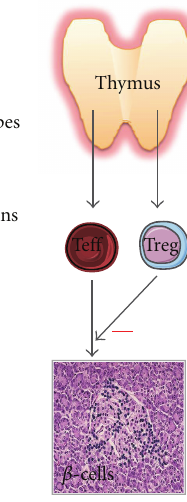
Figure 1: Thymus physiopathology and T1D development. Throughout life, the thymus selects self-tolerant and competent T cells against non-self-antigens and generates self-specific nTreg. Under control by AIRE for most of them, thymic epithelium transcribes genes encoding T1D-related antigens, as well as other neuroendocrine-related and tissue-restricted antigens. Absence or decrease in presentation of thymic T1D-related antigens (as observed in di ff erent animal models of autoimmune diabetes) conducts to the enrichment of the peripheral T-cell pool with “forbidden” self-reactive T cells (Te ff ) bearing a TCR directed against T1D-related epitopes, while thymic generation of specific nTreg is severely impaired. Combination of these two events is responsible for the breakdown of central self-tolerance to islet β cells. Both genetic and environmental factors are involved in the establishment of a molecular bridge between anti- β cell self-reactive Te ff and islet β cell autoantigens. Once this bridge is formed, the autoimmune pathogenic response is triggered and leads to a progressive destruction of the β cell